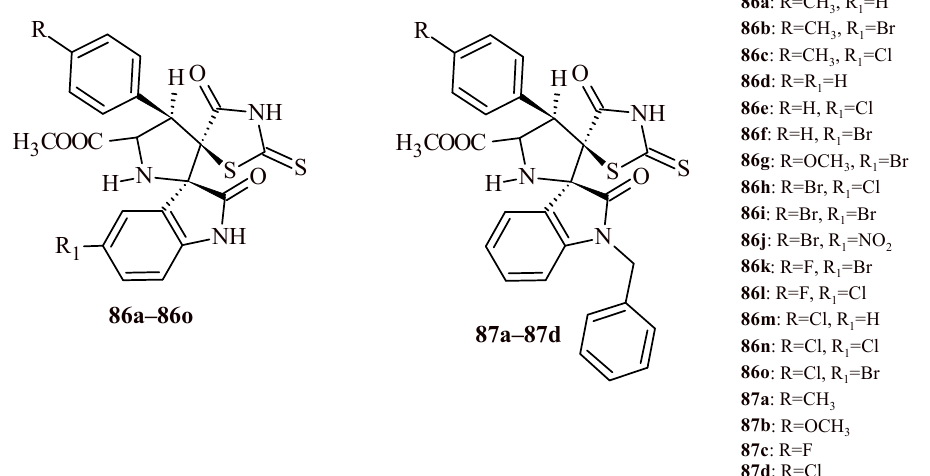
Figure 36. Three cyclic spiro rhodanine derivatives as α -amylase inhibitor.